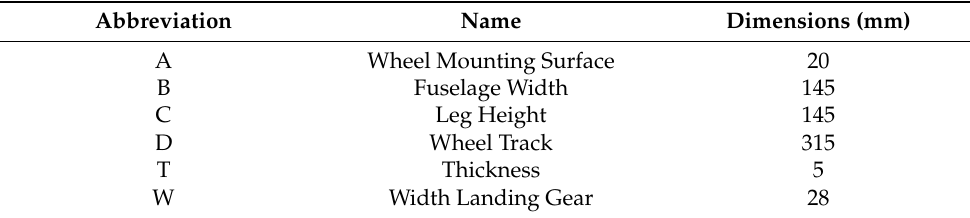
Table 1. Landing gear dimensions (3D printed and commercial aircraft landing gear).